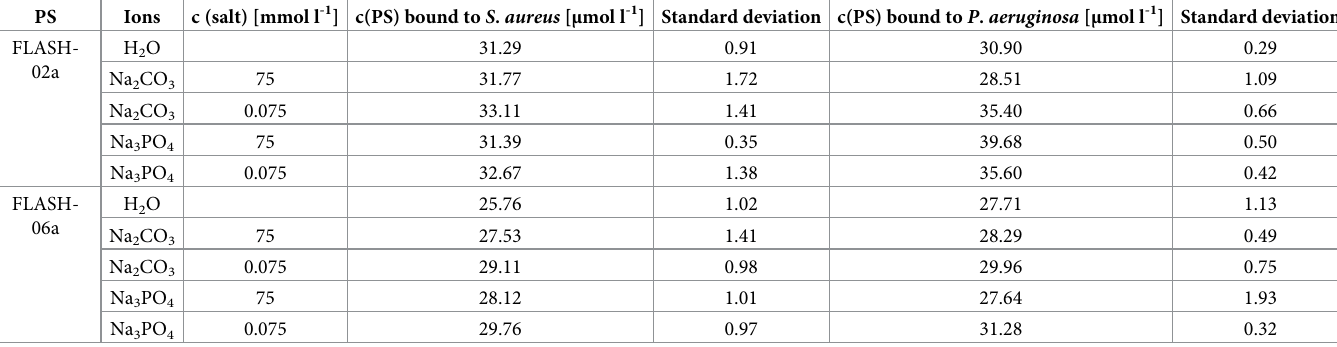
Table 1. Results of the binding